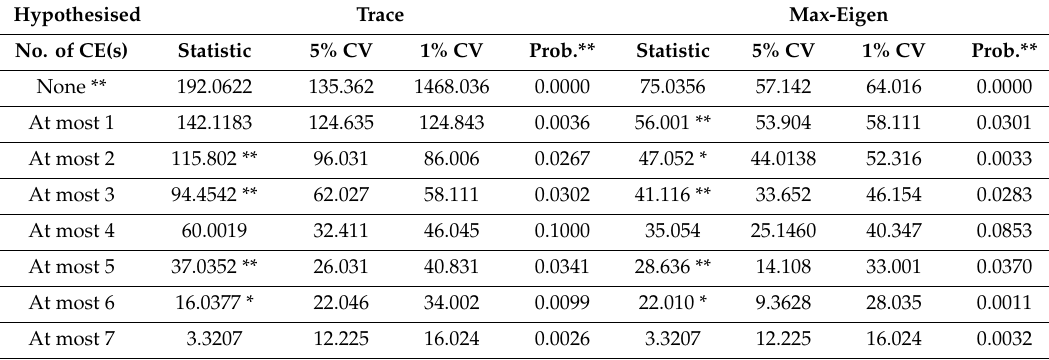
Table 5. Results of the cointegration